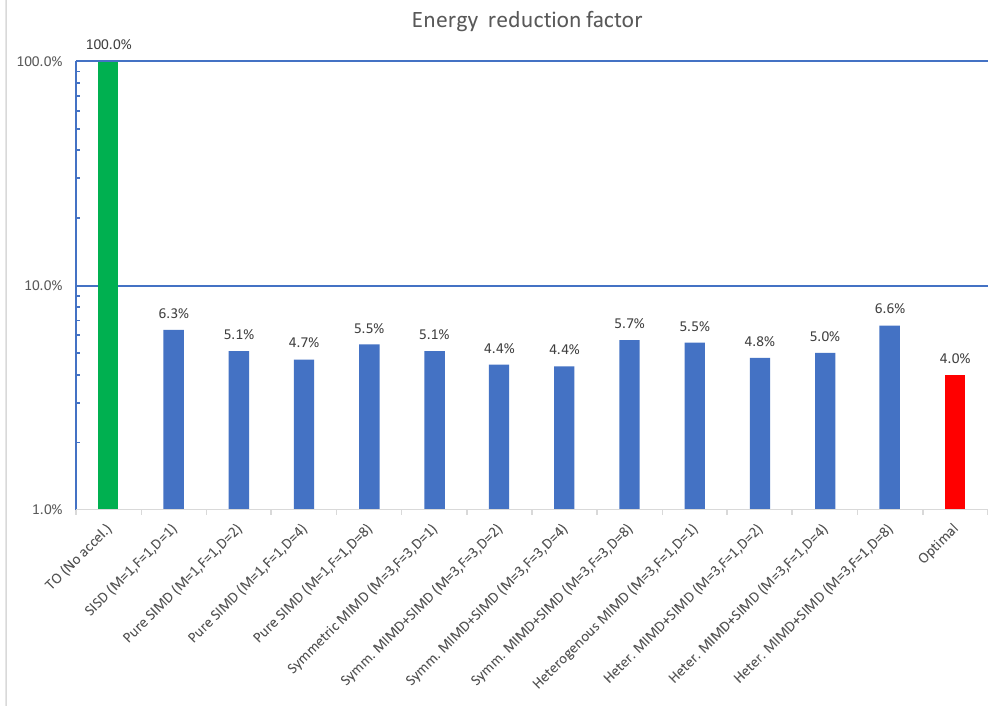
Figure 19. Energy reduction factor with respect to non-accelerated core (lower is better) obtained by each coprocessor configuration, along with the energy obtained by using the optimal configuration for each layer.